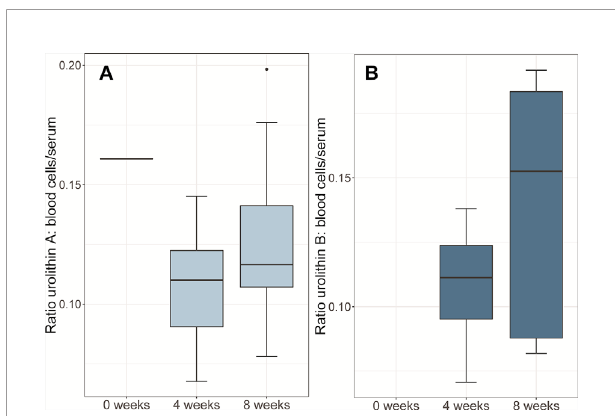
FIGURE 3 | Box-plots of urolithin concentrations ratios in blood cells related to serum after intake of Robuvit ® over 8 weeks: (A) urolithin A, (B) urolithin B. Ratios below 1.0 indicated that the compounds were predominantly present in